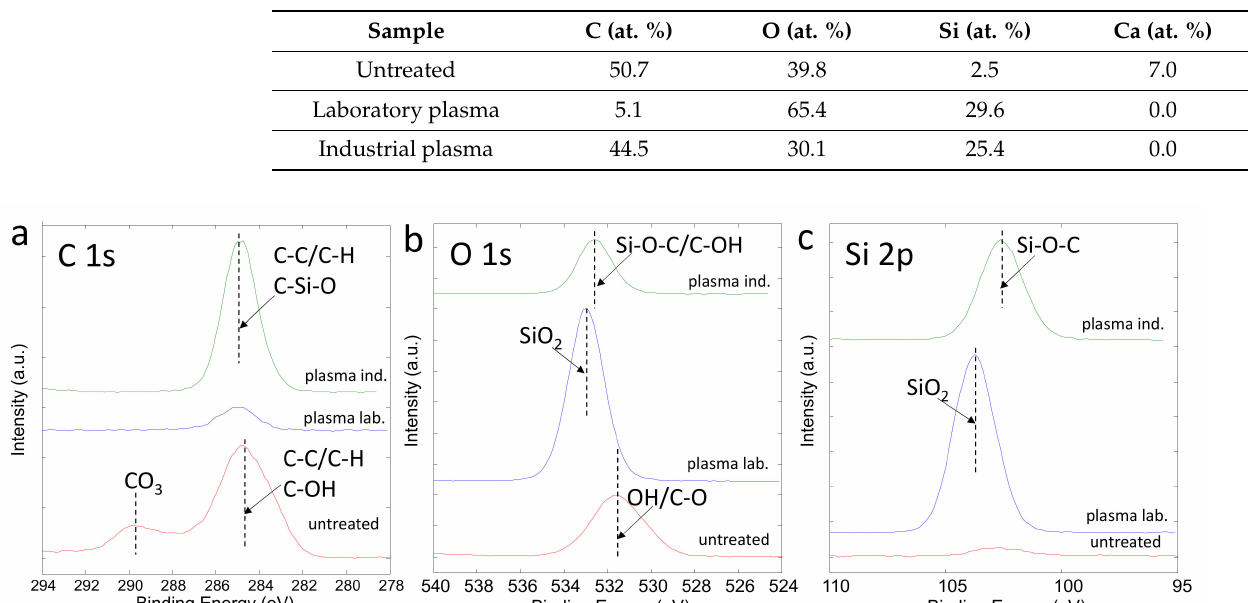
Figure 6. Surface composition in at.% of untreated, laboratory plasma, and industrial plasma treated samples analyzed by XPS method. Table 2. Surface composition in at.% obtained by XPS analyses.